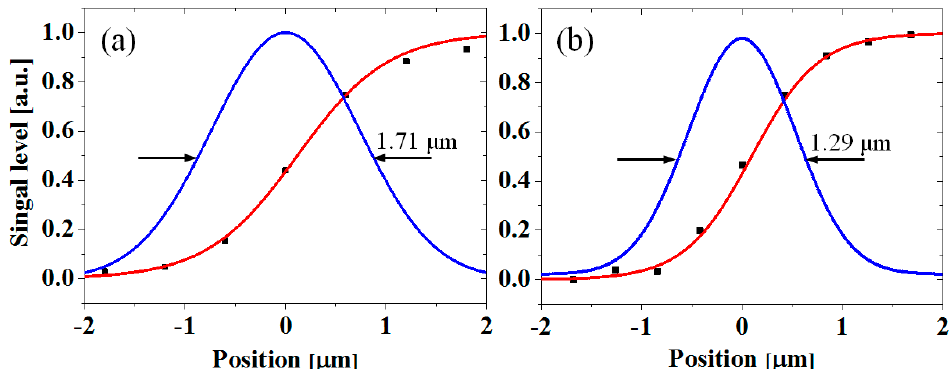
Figure 6. Spatial resolutions of backside thermoreflectance measurements using the ( a ) widefield and ( b ) confocal TRM systems with a 50× objective lens (NA 0.42). The symbols (solid squares) are the experimental data indicated by the solid lines in Figure 5c,d and were fitted to error functions (red lines). Gaussian PSFs (blue lines) were extracted based on the derivatives of the fitted curves. The position was measured from the edge of the poly-Si micro resistor.